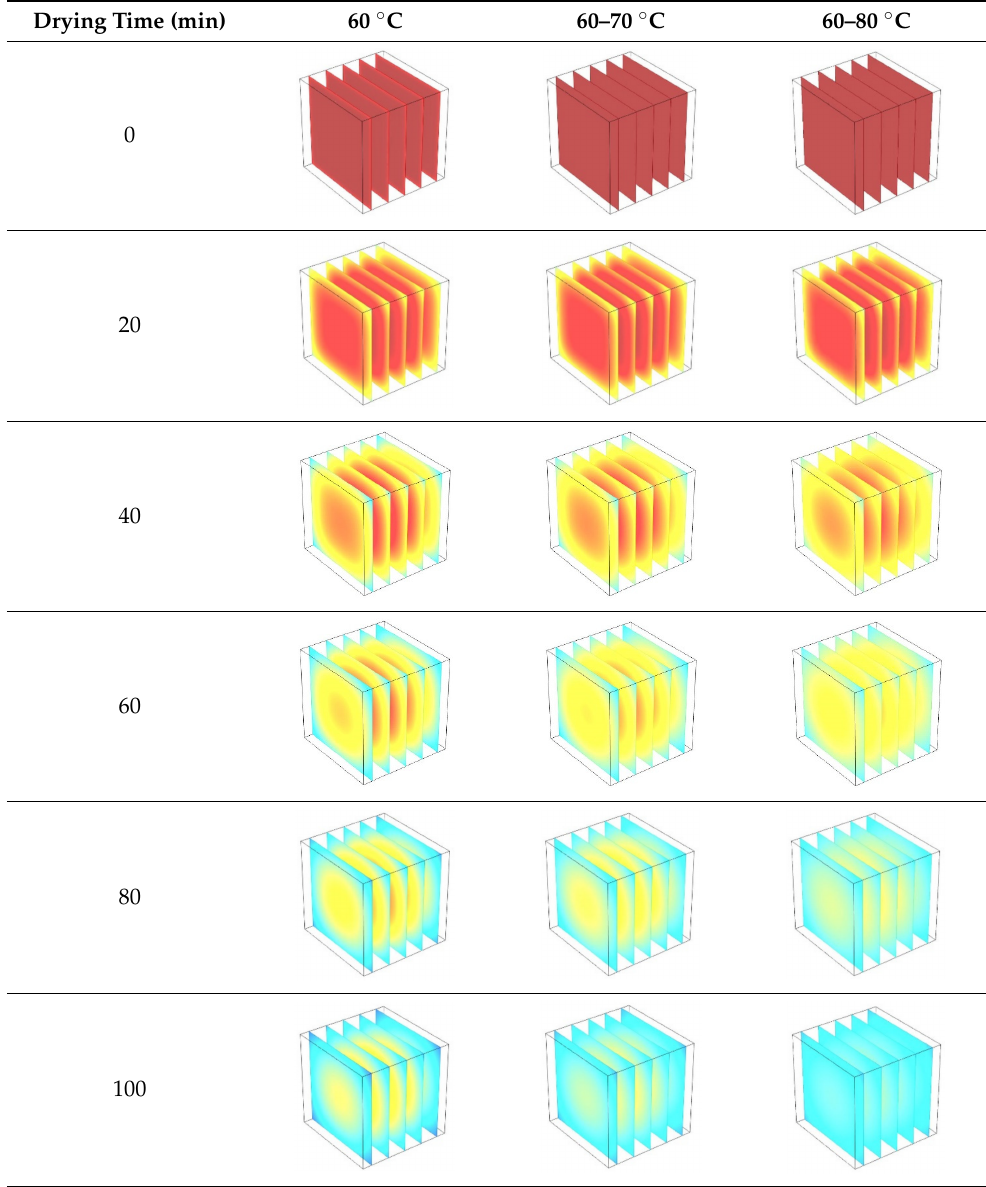
Table 2. Contour plots of simulated moisture content as a function of drying time.